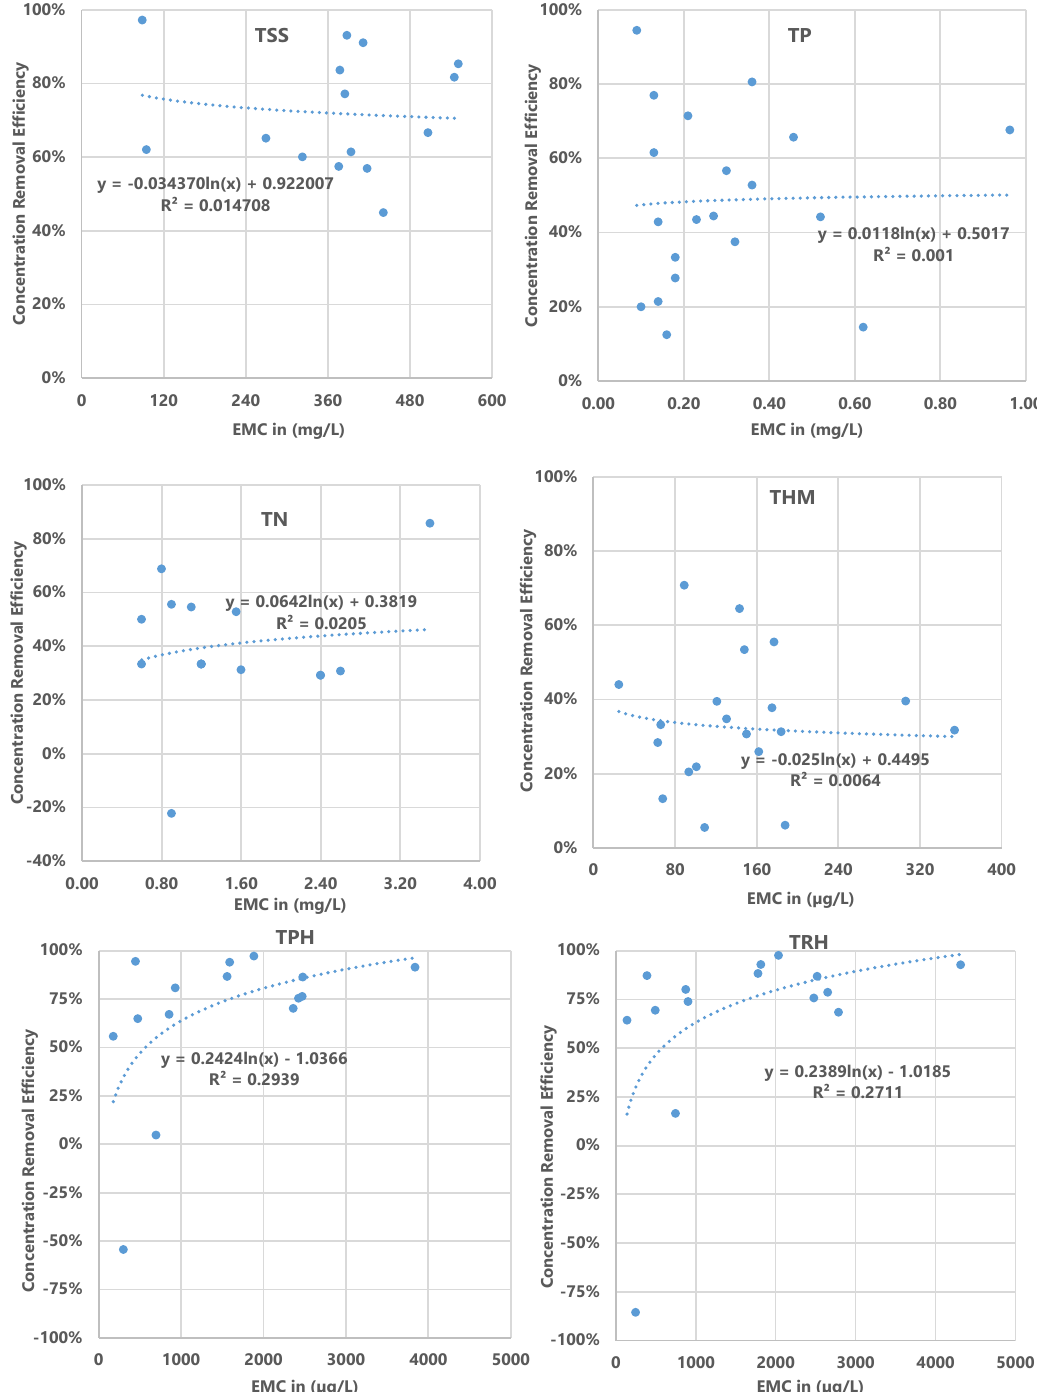
Figure 11. Concentration Removal Efficiency as a function of influent concentration for all pollutants.